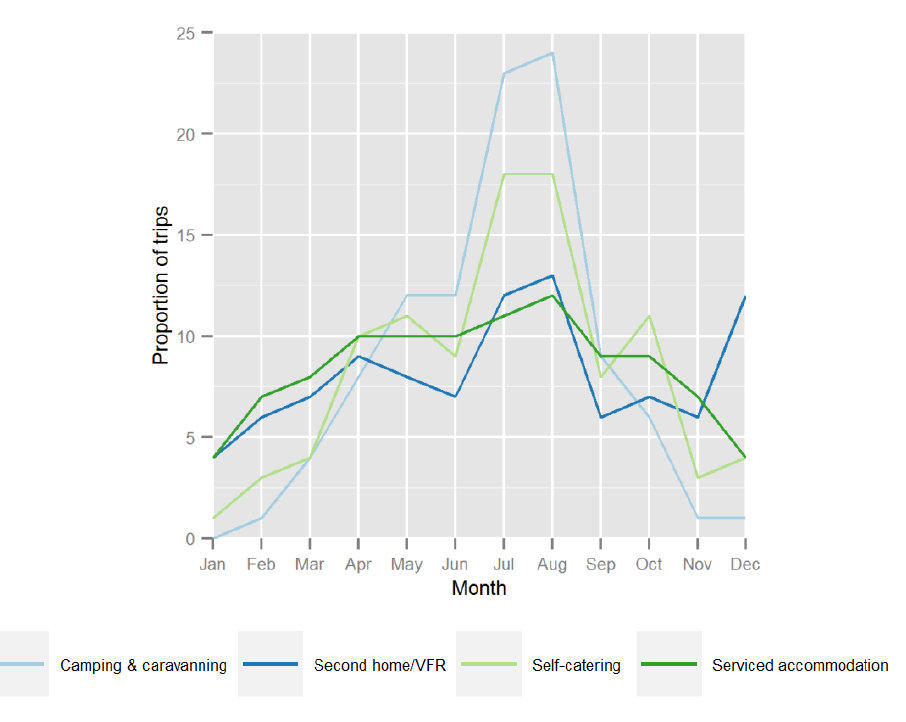
Figure 4. Seasonal trip distribution (all domestic trips) based on accommodation